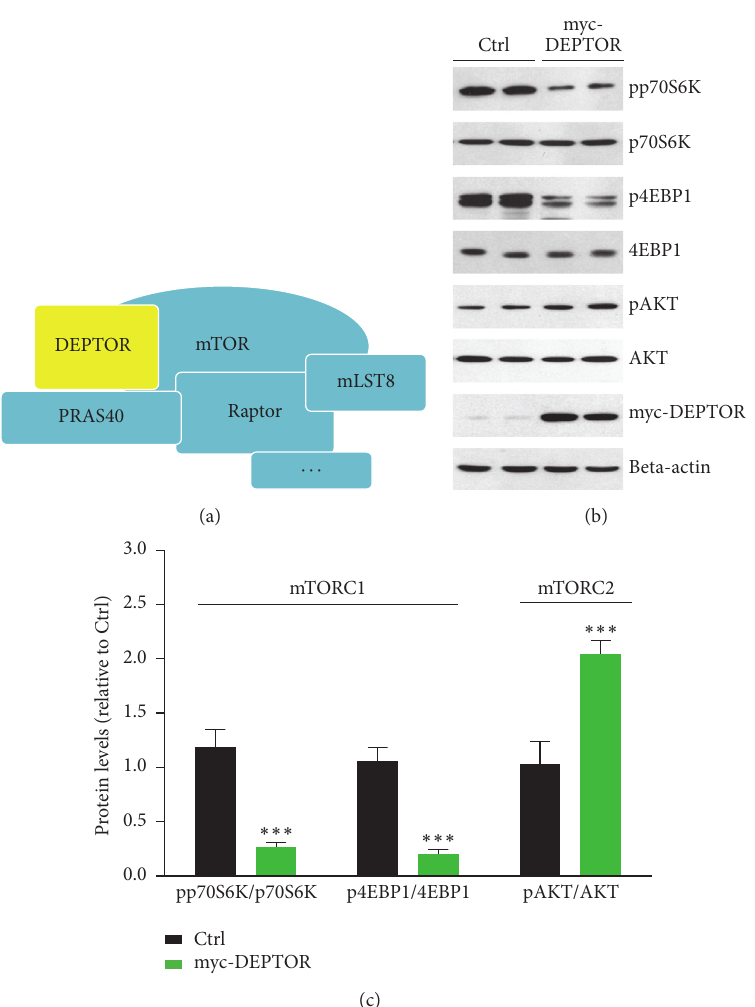
Figure 1: Overexpressed DEPTOR decreases mTORC1 and increases mTORC2 activity. (a) A schematic model showed the components of mTORC1 complexes. Raptor is the characterized adaptor protein of mTORC1, and mTOR works as the kinase to phosphorylate downstream substrates. DEPTOR is the natural inhibitor of mTORC1. (b-c) Western blots and quantifications showed that mTORC1 activity, indicated by phosphorylations of p70S6K and 4EBP1, was downregulated by myc-DEPTOR overexpression in lymphocytes of PBMC culture. Results are averages of three independent experiments. Data represent mean ± SEM. ∗∗∗ 𝑃 < 0.001